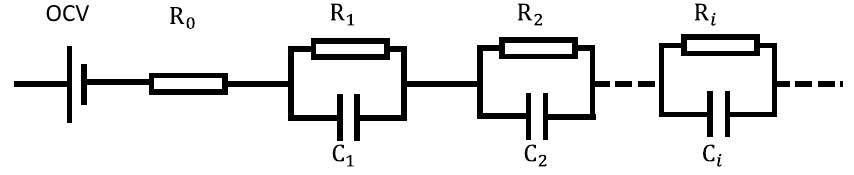
Figure 7. Equivalent circuits model of battery cells.